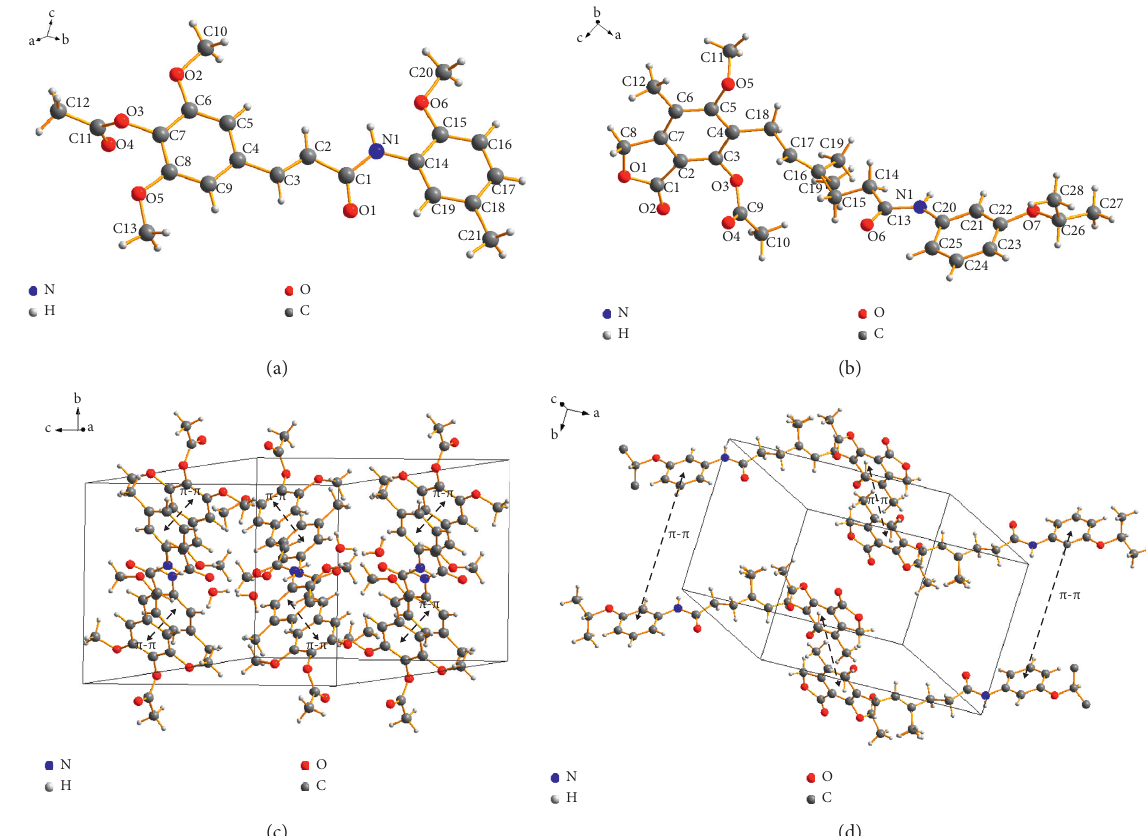
Figure 4: Crystal structures of I-4 (a) and II-5 (b), and crystal packing of I-4 (c) and II-5 (d).